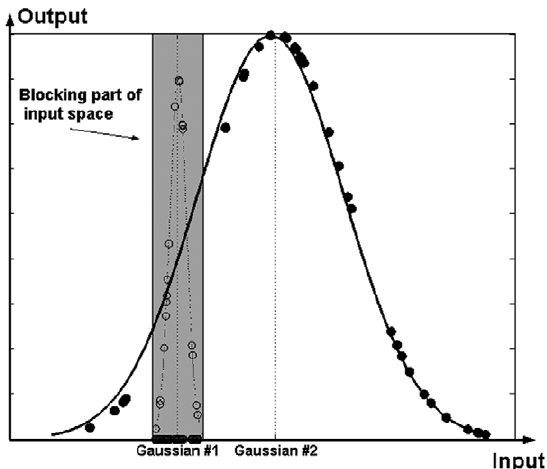
Figure 1. Activation function overlapping problem.